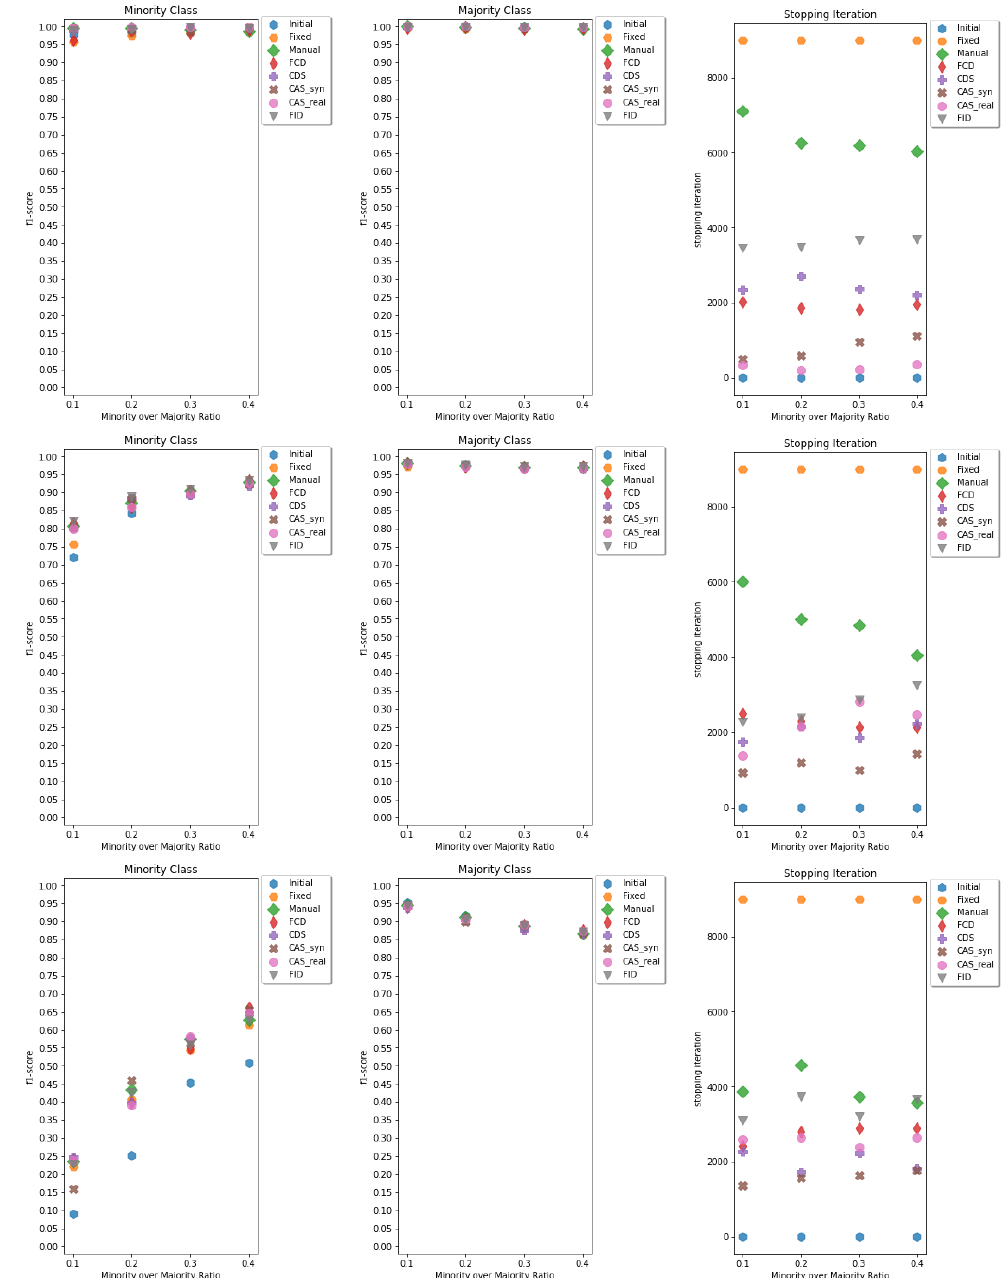
Figure 19. Average F1 results of fmnist17 ( top ), fmnist79 ( middle ), and fmnist24 ( bottom )-based datasets by imbalance ratio for minority ( left ) and majority ( center ) classes, and average number of iterations until the training is stopped ( right